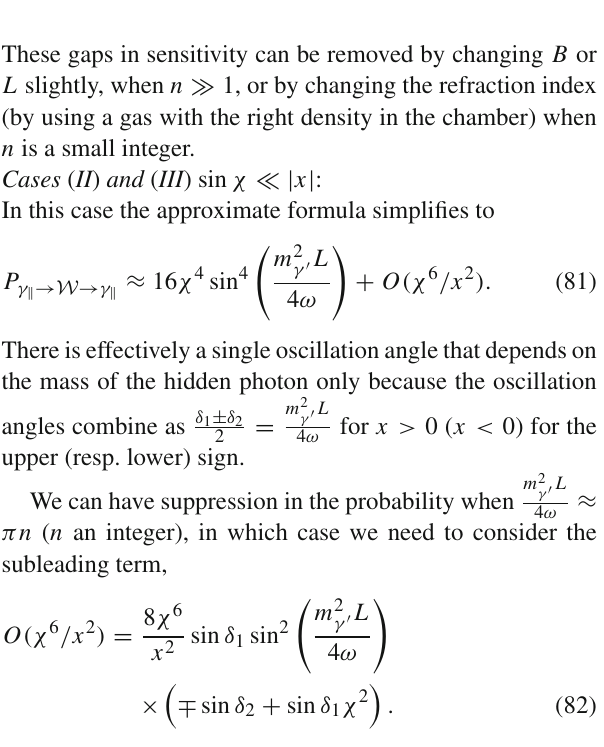
Fig. 6 Exclusion region in the ALP plane region g vs. m φ using ellipticity measurements for different pairs of HP coupling and masses. We have assumed B = 2 . 5 T, L = 1 m and ω = 1 eV from [17]. See discussion in Sect. 4.1 of the